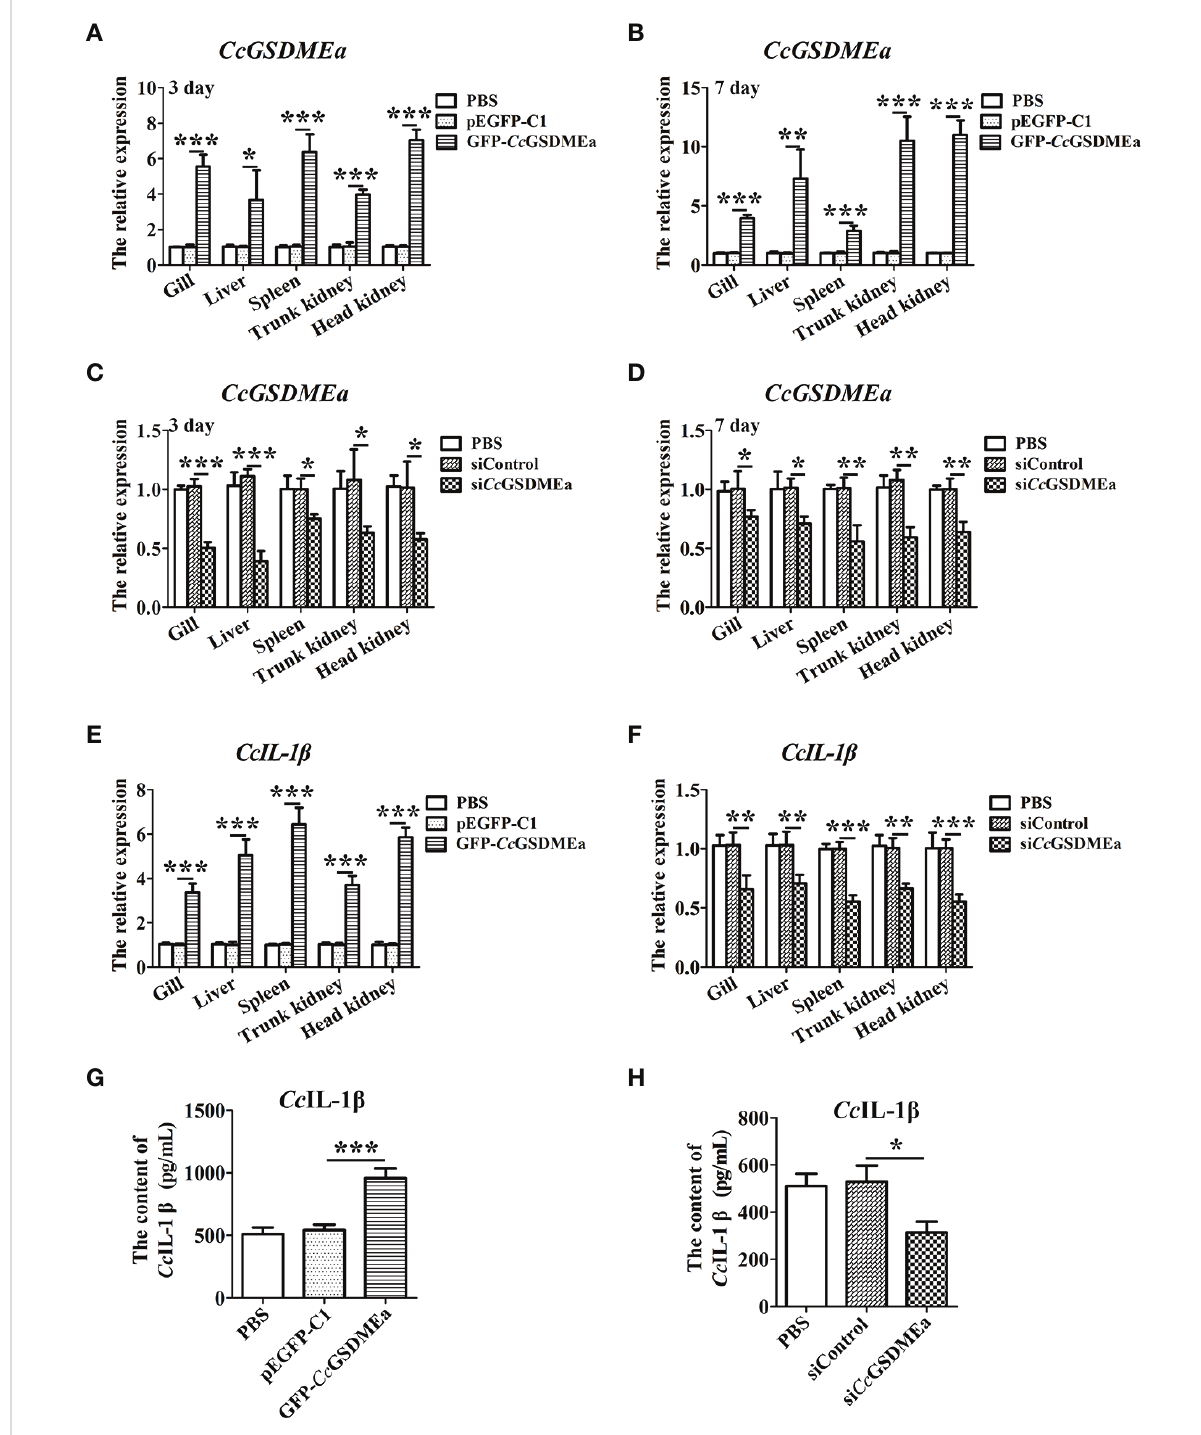
FIGURE 7 Cc GSDMEa promotes the expression of Cc IL-1 b in vivo . (A-D) Overexpression ef fi ciency and knockdown ef fi ciency of Cc GSDMEa in gill, liver, spleen, trunk kidney and head kidney of C. carpio . (E, F) The mRNA expression levels of Cc IL-1 b in the different groups after A. hydrophila challenge. (G, H) The protein expression levels of Cc IL-1 b in the different groups after A. hydrophila challenge. In each case, the mRNA expression level in the PBS group was chosen as calibration (set as 1). The statistical difference was analyzed by student ’ s t test ( * , P < 0.05; ** , P < 0.01; *** , P <